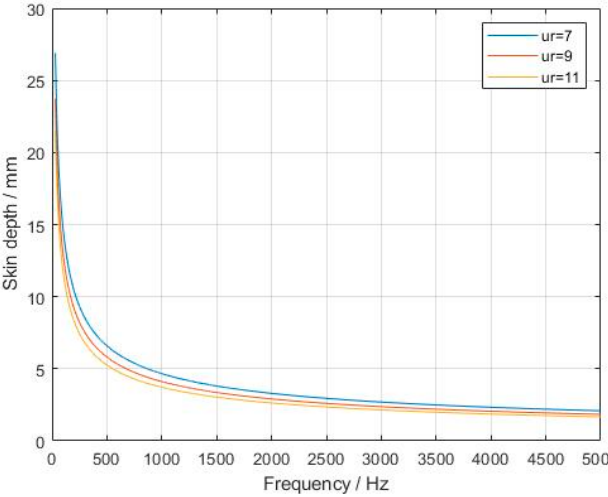
ff erent relative permeabilities.